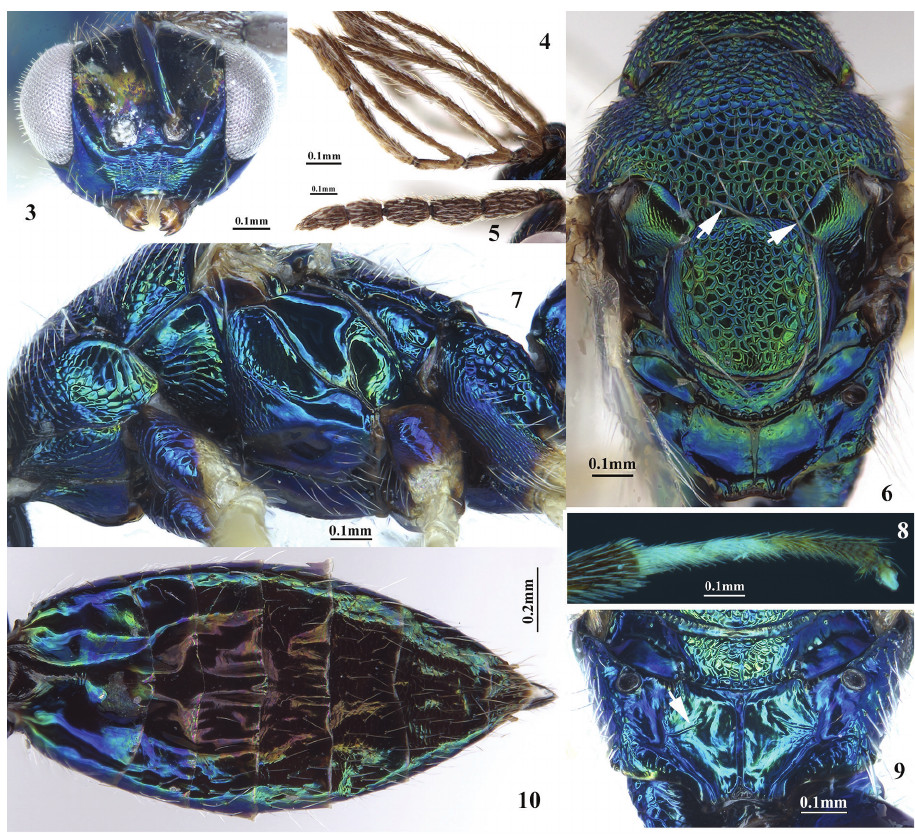
Antennal flagellum 5 Antenna 6 Mesosoma, dorsal view (bristle, arrow) 7 Mesosoma, lateral view 8 Hind tarsi 9 Propodeum (costula, arrow) 10 Metasoma, dorsal